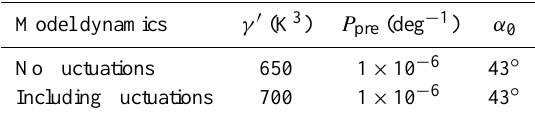
Table 2. The parameters to be used in the NAT nucleation param- eterisation, for models which include a representation of the atmo- spheric dynamics leading to small-scale temperature fluctuations, and for models which do not include such a